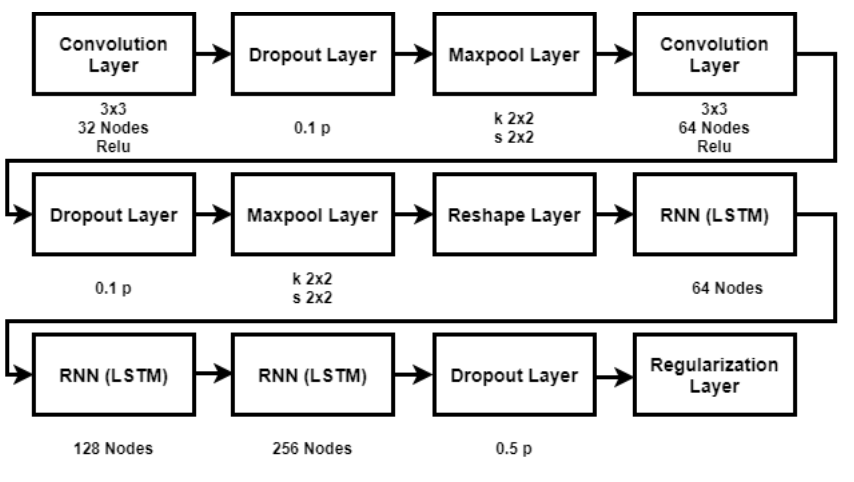
Figure 4. Proposed model block diagram.